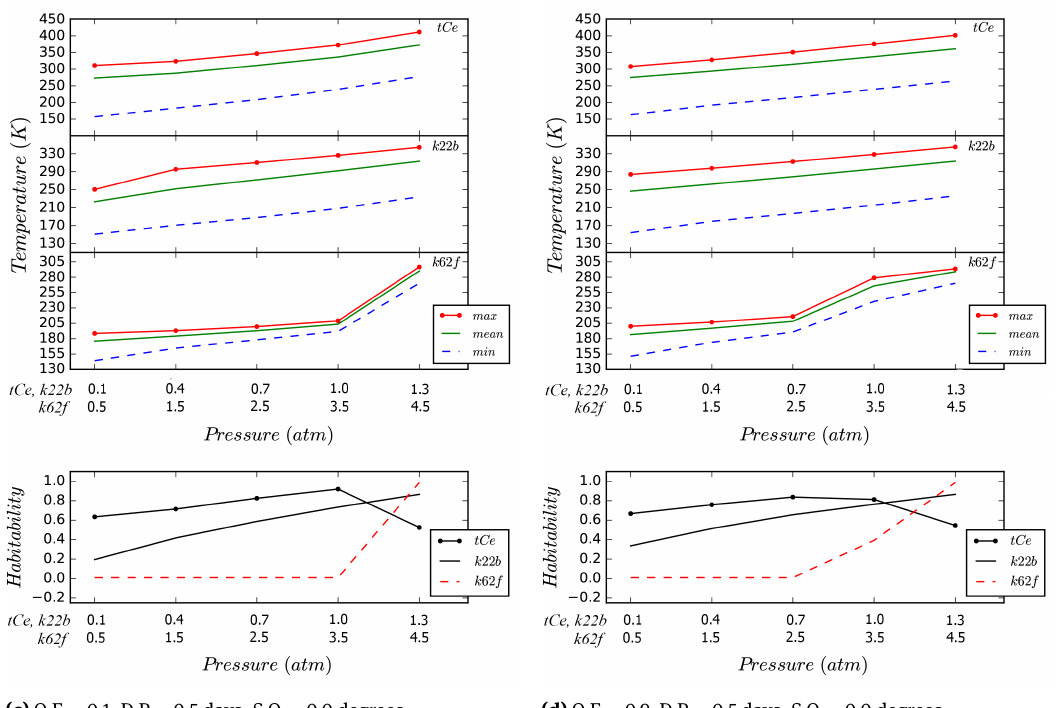
Figure 1. Pressure varies; for planet τ Ceti e (tCe), Kepler-22b (k22b), p = (0.1, 0.4, 0.7, 1.0, 1.3) atm; and for Kepler-62f (k62f), p = (0.5, 1.5, 2.5, 3.5, 4.5)